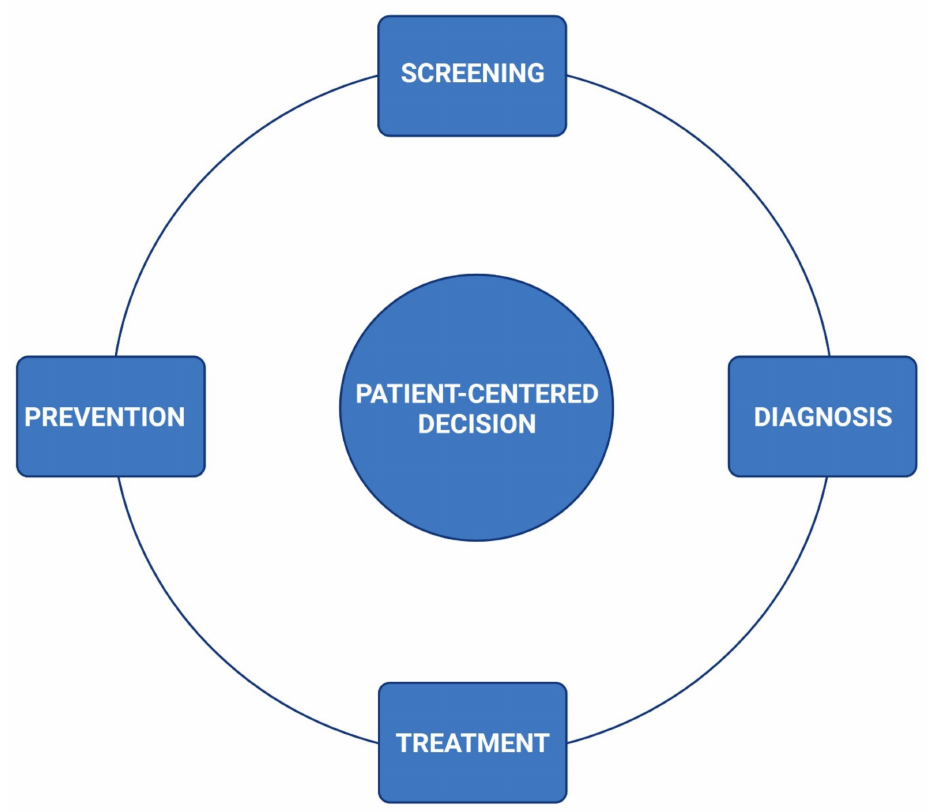
Figure 2. Conceptual model of a continuum of cardiovascular care for children undergoing oncology therapies. Created with